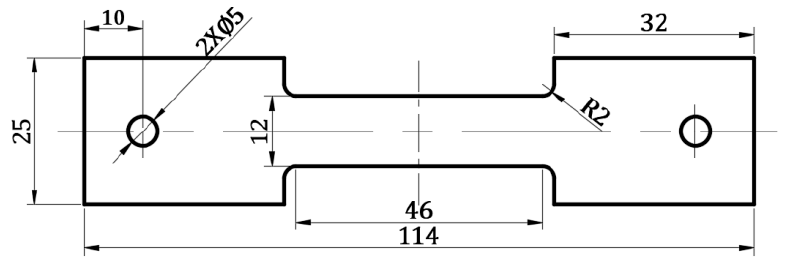
Figure 2. Specimen of Gleeble hot uniaxial tensile test (All dimensions are in mm).